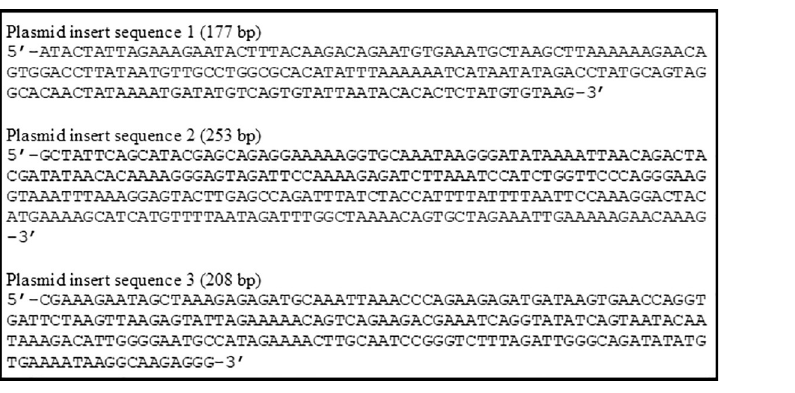
Fig 3. OROV sequences in plasmids.